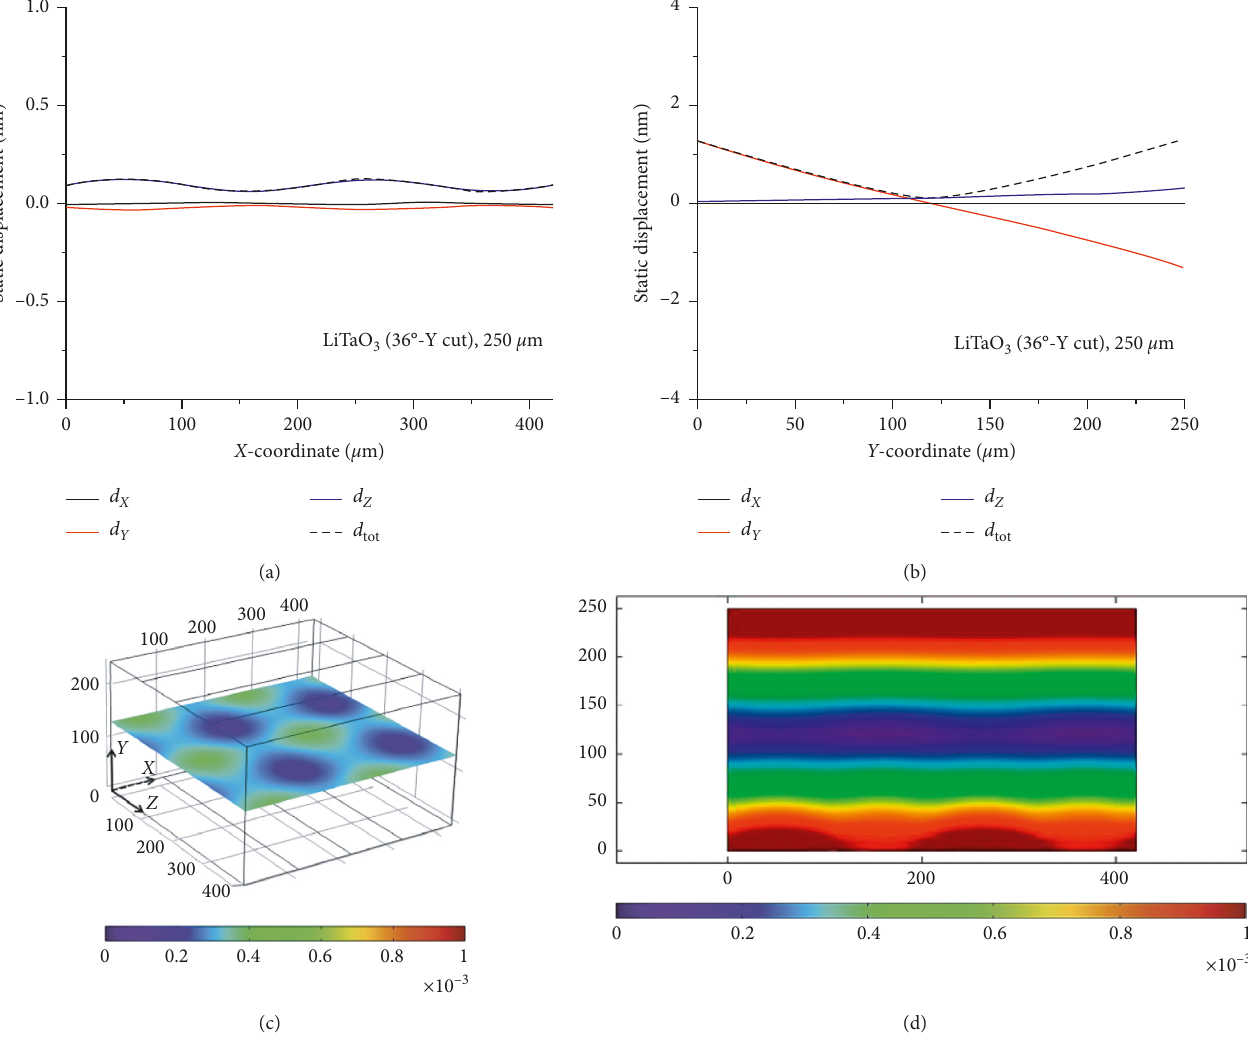
Figure 5: Static displacement distribution at a crystal thickness of 250 μ m measured in μ m for the case of the apposite electric potentials applied to the top and bottom ESs. The d X , d Y , d Z , and d tot components of the static displacements measured (a) at the middle of the crystal along X -axis direction and (b) along thickness. Total static displacement measured (c) in the middle of the crystal and (d) along the